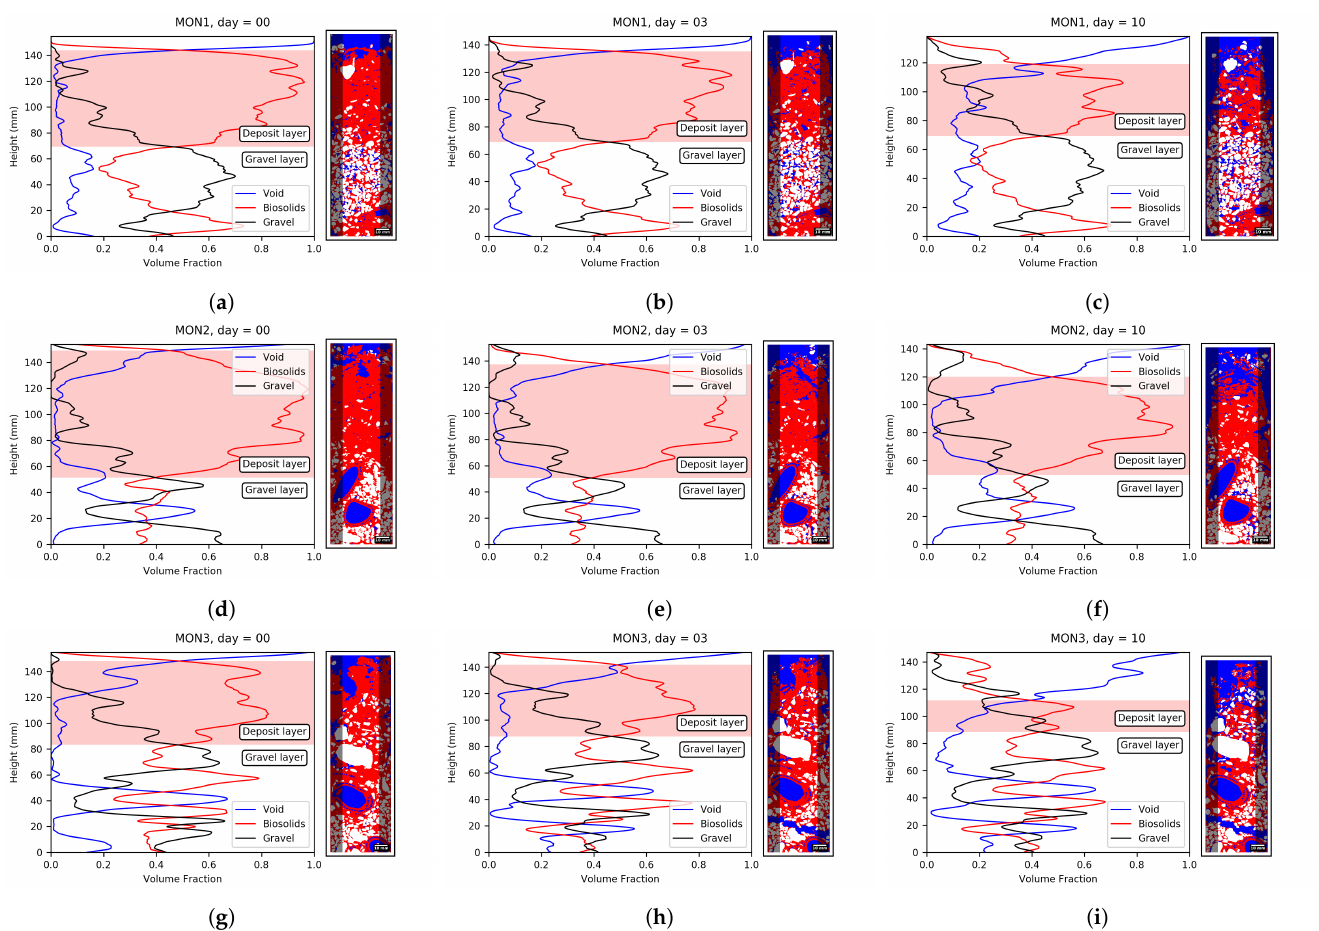
Figure 4. Evolution of vertical phase volume fraction profiles and snapshot on a vertical slice of the 3D scan. Computation were performed for a ROI of 60%. ( a ) MON1, day 0, ( b ) MON1, day 3, ( c ) MON1, day 10, ( d ) MON2, day 0, ( e ) MON2, day 3, ( f ) MON2, day 10, ( g ) MON3, day 0, ( h ) MON3, day 3, ( i ) MON3, day